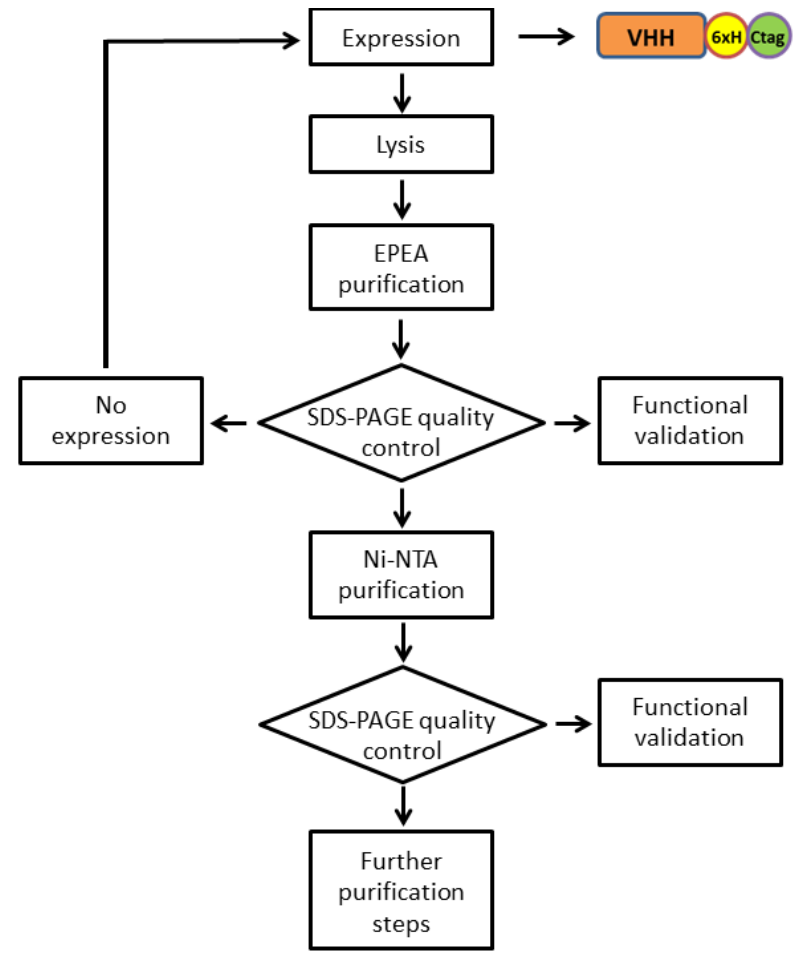
Figure 2. Flow-chart of the purification protocol used for recovering homogeneous proteins fused to both 6xHis and C tags. The presence of both C and 6xHis tags enables two orthogonal steps of affinity purification. A protein quality control (functionality, contamination, degradation) can be performed after each purification step to evaluate the necessity to stop the procedure or to pass to the next purification